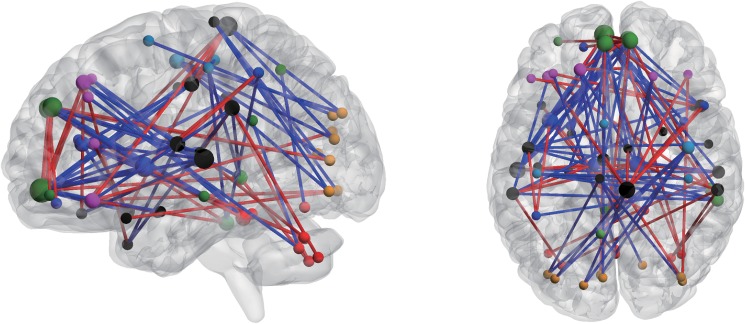
Consensus functional connections demonstrated in the left and top view.Regions are color-coded by category and size-coded by weight as in Fig 3. Red lines represent increased functional connections, and blue lines represent decreased functional connections.